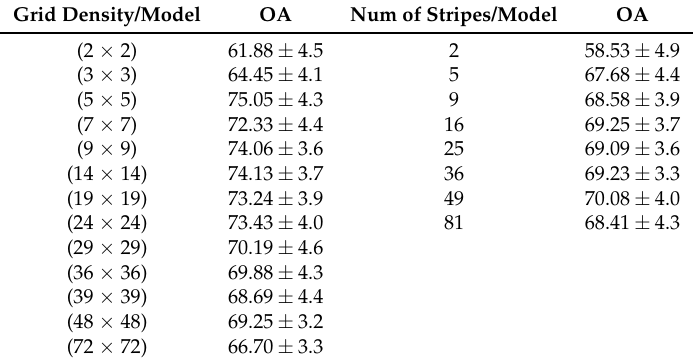
Table 2. The second experiment results. Grid density describes number of rectangular patches which represent artificial labels for pre-training phase. Num of stripes denotes number of vertical stripes that represent artificial labels for pre-training phase. Accuracies are given as Overall Accuracy for learning of the network based on [16] with transfer learning on the Indian Pines dataset.